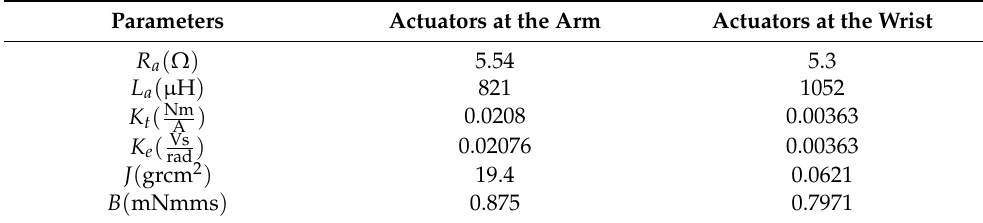
Table 1. Actuator